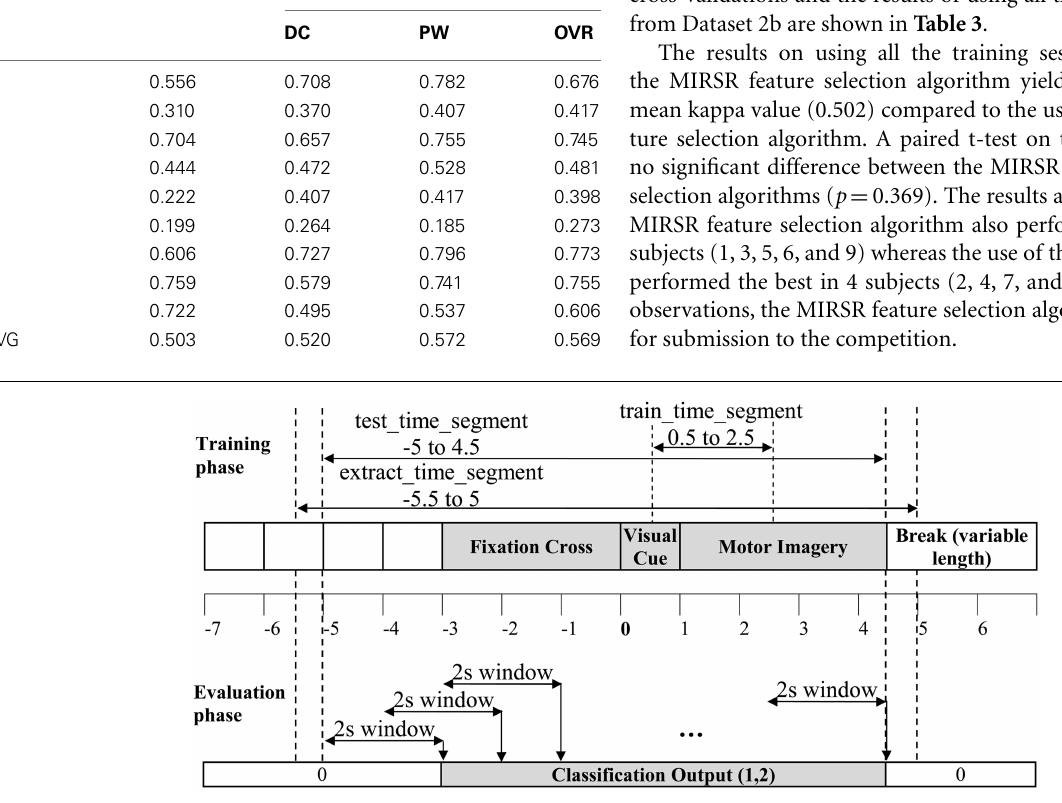
FIGURE 3 |The illustration on the extraction of a single-trial EEG segment from the training data for the FBCSP training phase in Dataset